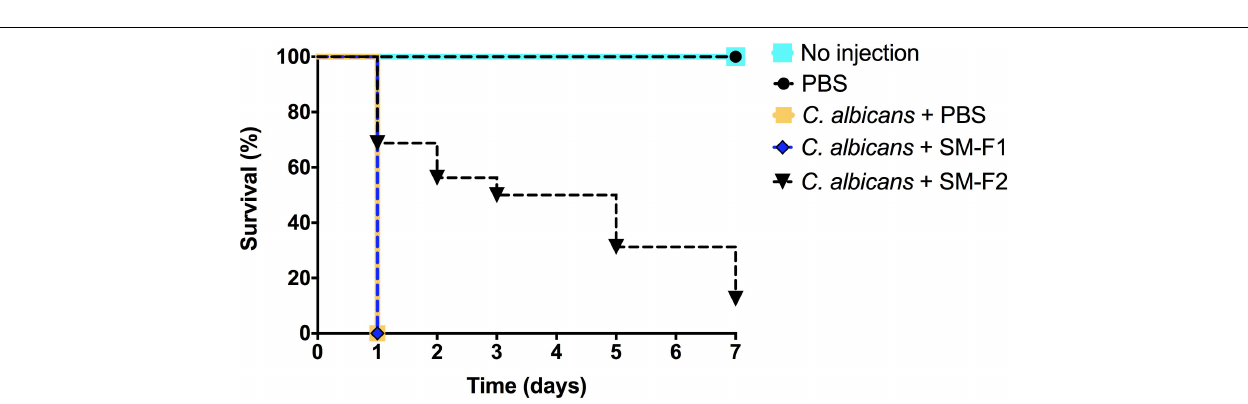
FIGURE 5 | G. mellonella survival assays. Antifungal activity of SM-F1 (15 mg/mL) and (SM-F2 15 mg/mL) on larvae infected by C. albicans . Statistically significant difference was observed between the group treated with SM-F2 and non-treated control group (PBS) ( p < 0,0001). Log-rank test (Mantel-Cox).